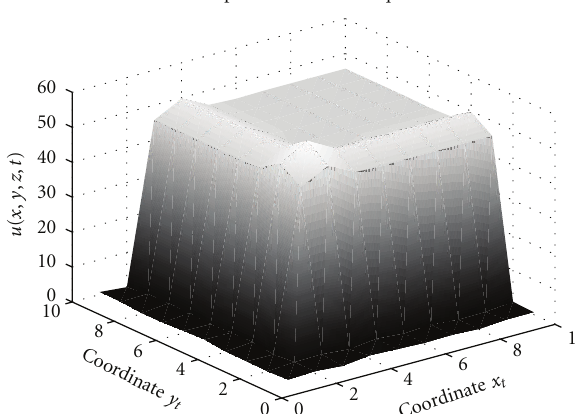
Figure 2: Numerical trajectory produced by the mathematical model described by 3D partial di ff erential equation at time 10 s along the whole domain.